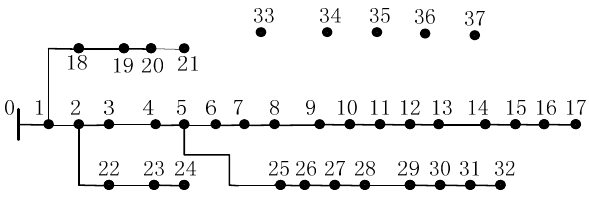
Figure 11. The topological structure of the institute of electrical and electronic engineers 33(IEEE33) node power distribution system.